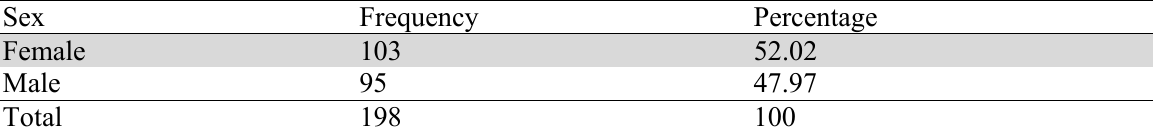
The Frequency of Samples